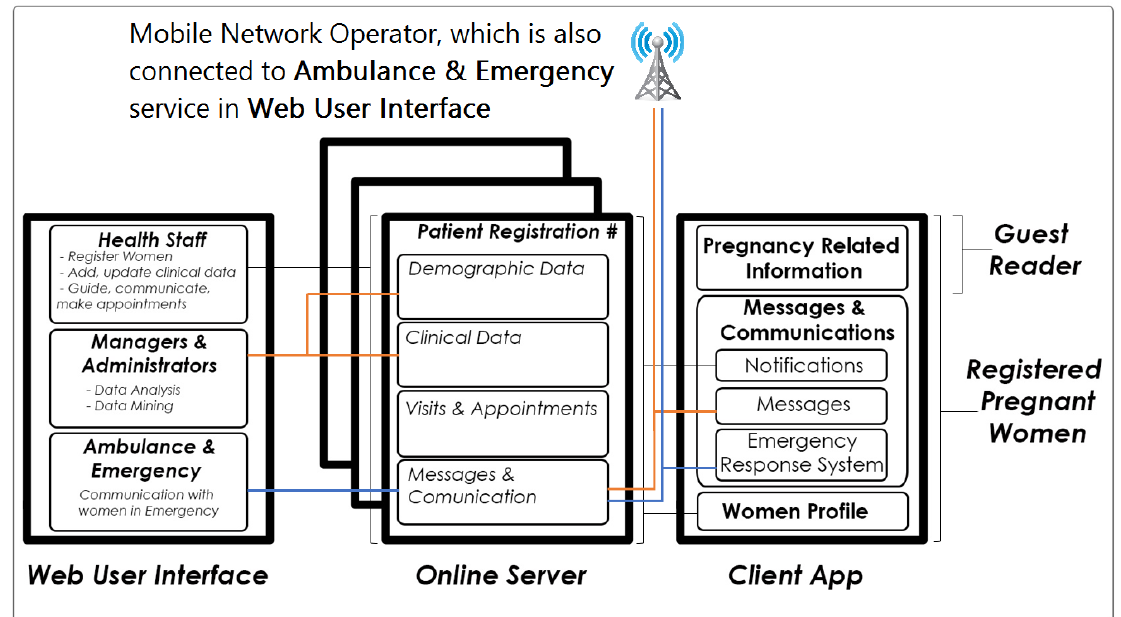
Figure 3. Components and function of the pregnancy care